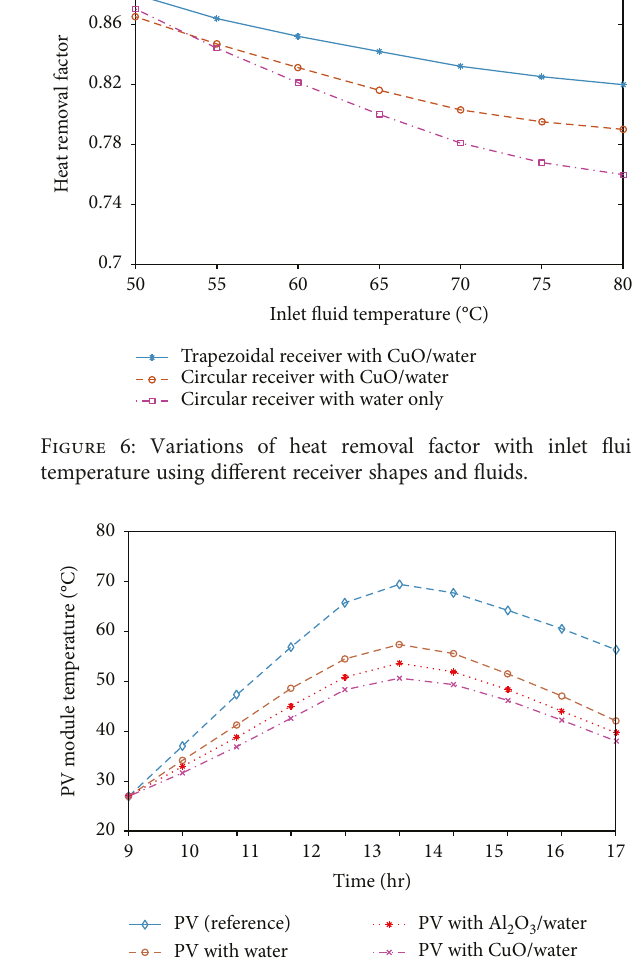
Figure 7: Daily variations of PV temperature with CuO/water, Al O /water, and 2 3